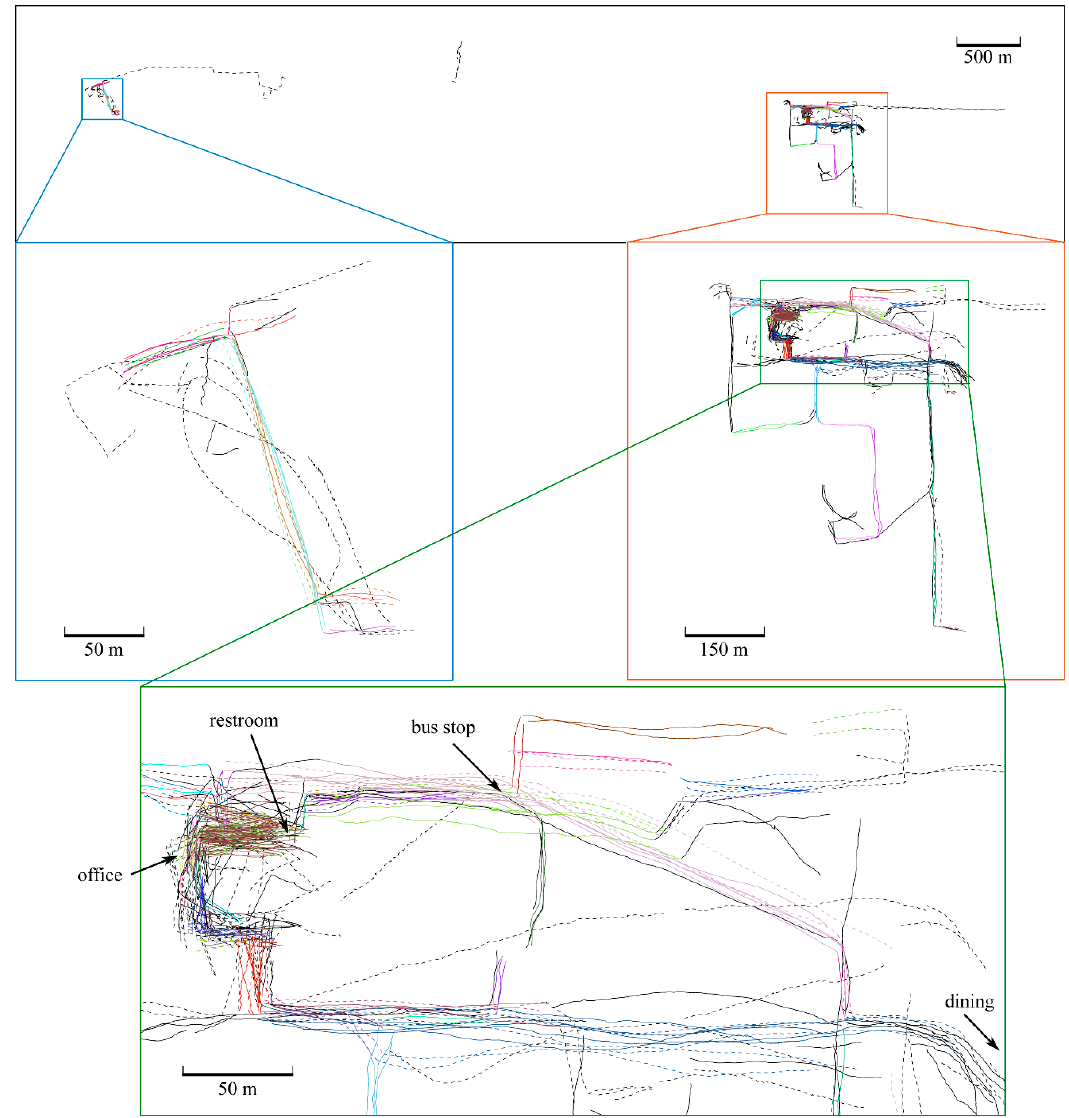
Figure 5. Straight walking trajectories reconstructed during a 10-day walking test, including proper relative geographic location (absolute coordinates removed). The subject wore athletic shoes (solid lines) and sandals (dashed lines) for 5 days each. The figure shows all straight paths longer than 15 m over all 10 days. Matched clusters are shown in different colors, and un-clustered paths are shown in black. The same route traversed in opposite directions counts as two separate paths. Gaps and disconnects in the data arise from several sources, such as: Stationary periods; walking bouts less than 15 m long; corners and other turns; travel by car, bus or bicycle; erroneous path reconstructions; and any other path that did not satisfy the criterion “straight paths longer than 15 m”. Note: this figure is available in vector graphics format in the Supplementary Material for closer study.